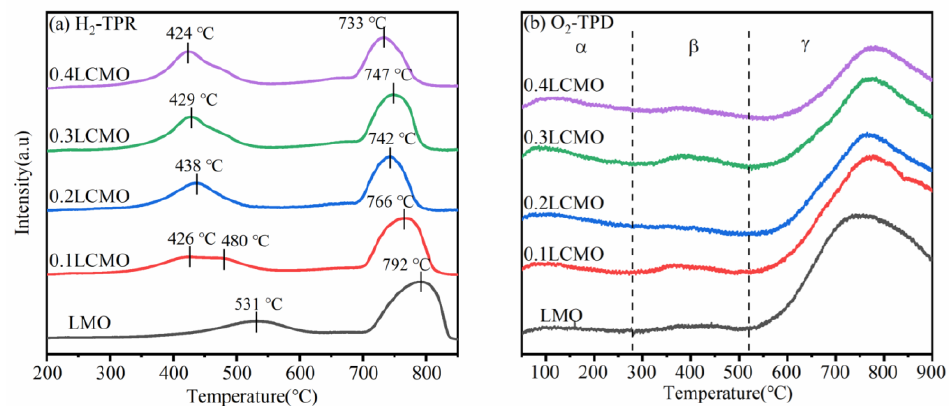
Figure 5. H 2 -TPR ( a ) and O 2 -TPD ( b ) results of the oxygen carriers. Figure 5. Results of the oxygen